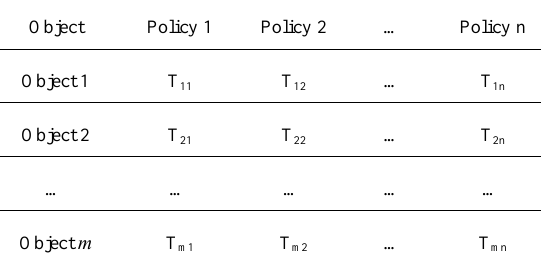
Table 4. Trust evaluation table for risk